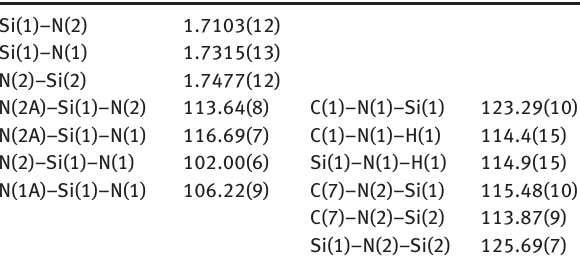
Figure 6: Molecular structure of 4b-TMS2 including numbering scheme. The thermal displacement ellipsoids of the non-hydrogen atoms are drawn at the 50% probability Table 4: Selected geometric parameters (Å, °) of 4b-TMS2